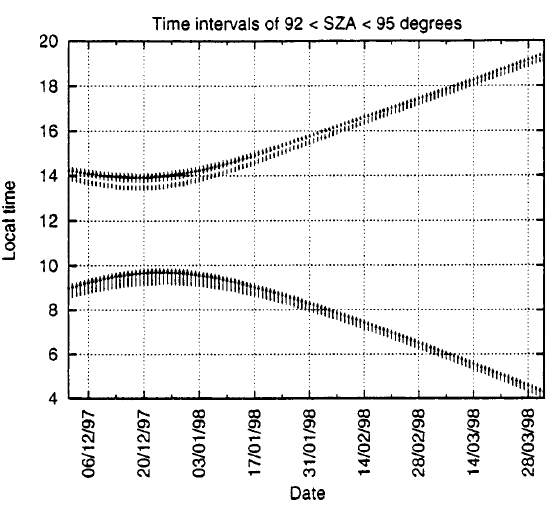
Fig. 3. Time intervals (marked by arrows ) of 92 (cid:176) < SZA < 95 (cid:176) calculated for Kiruna (68 (cid:176) N, 20